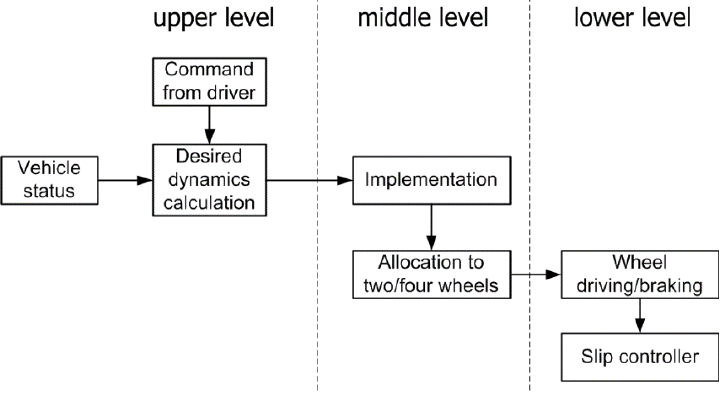
Figure 6. Three-level dynamic control structure of